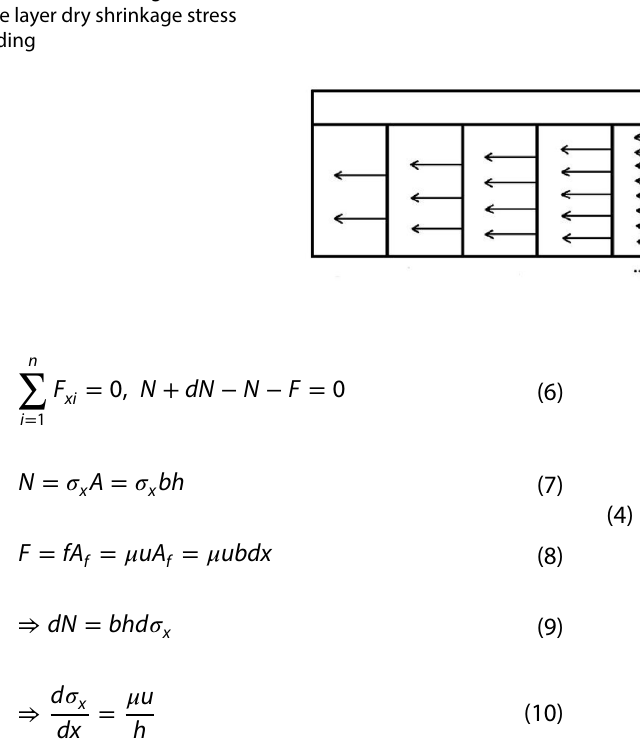
Fig. 3 Schematic diagram of base layer dry shrinkage stress